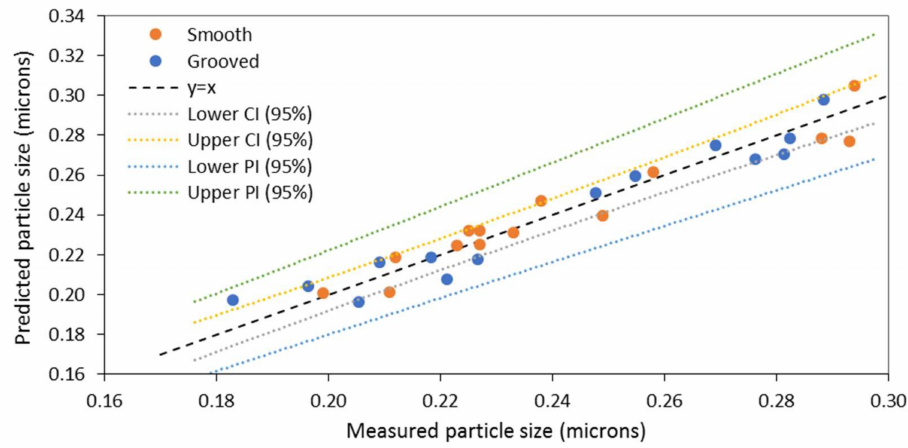
Figure 5. Comparison between predicted particle size and experimental particle size for smooth and grooved discs using the rotational Reynolds number ( Re ω